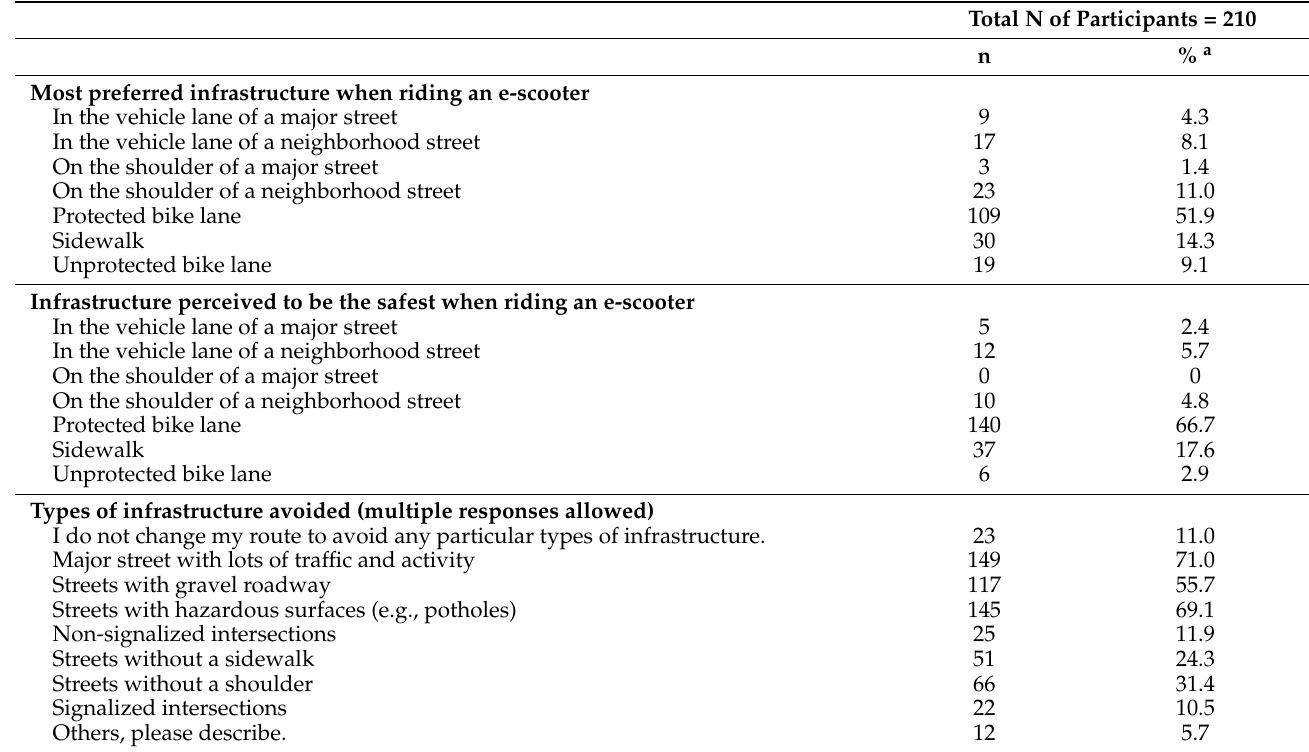
Table 5. Riders’ perceptions of various types of